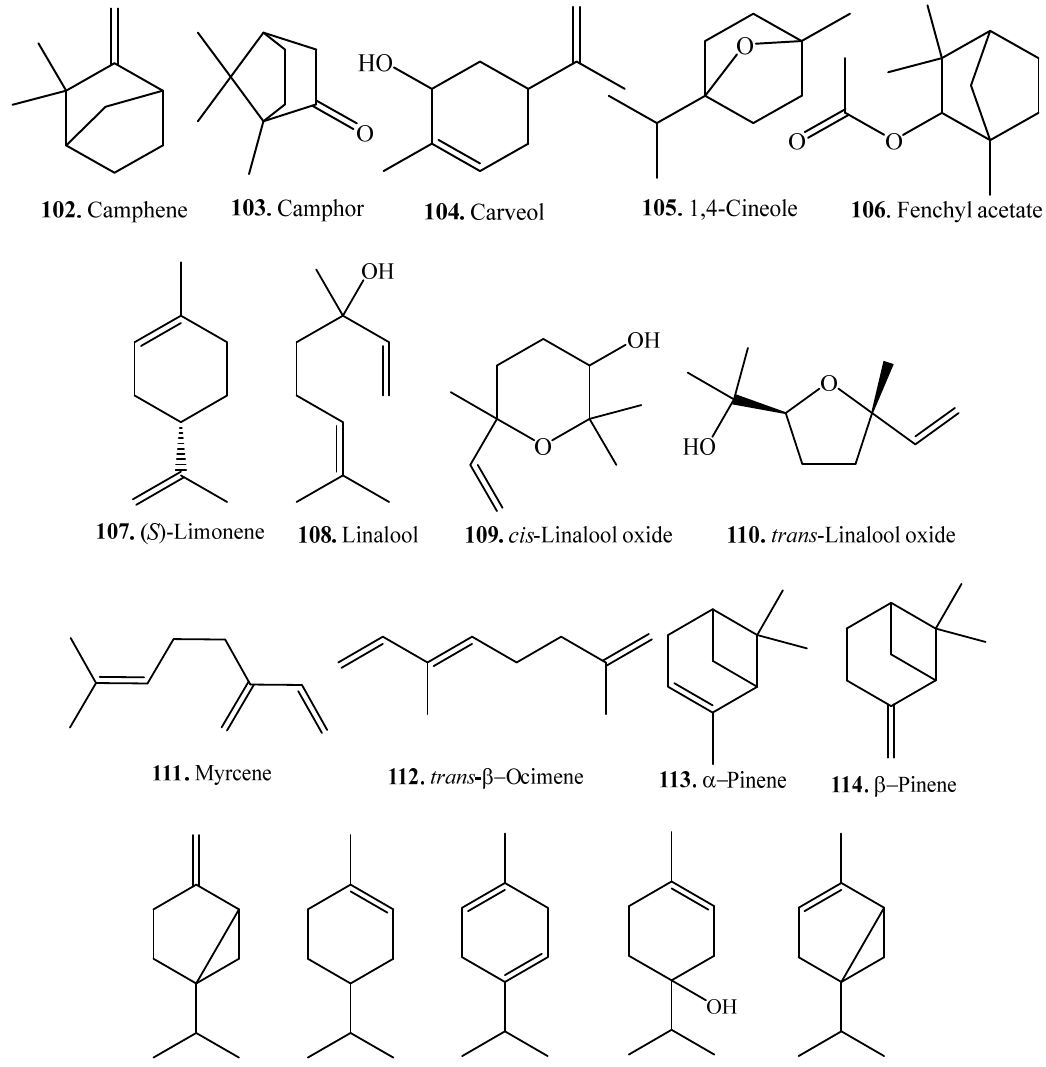
Figure 3. Structures of the monoterpenoids identified in rice.